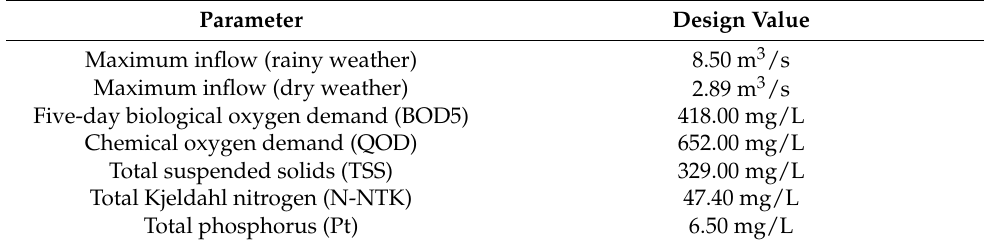
Table 1. Design parameters of wastewater treatment plant of Villapérez (Asturias, Spain).